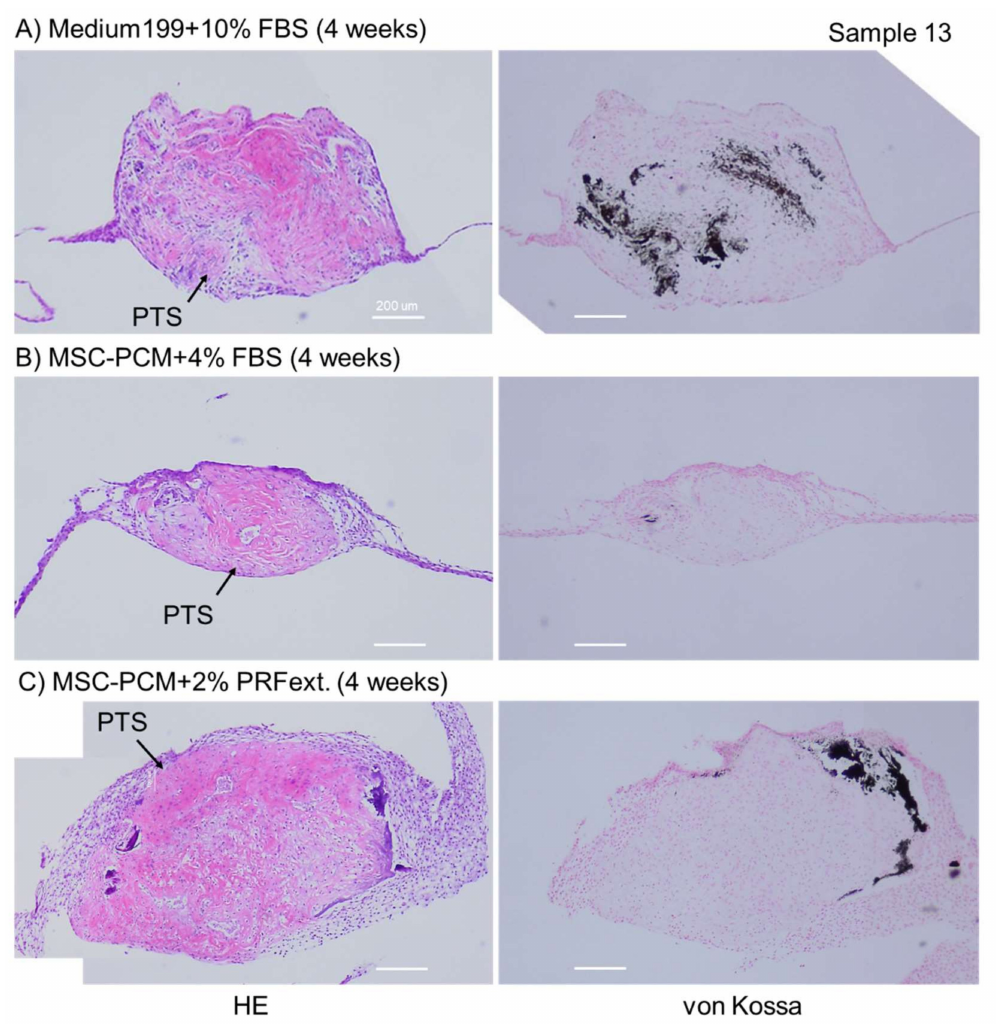
Figure 5. Effects of different culture media on the thickness of periosteal sheets. In von Kossa staining, calcium deposits were stained black. These data are representative of five independent experiments. hematoxylin and eosin (HE) staining. Bar = 200 µ